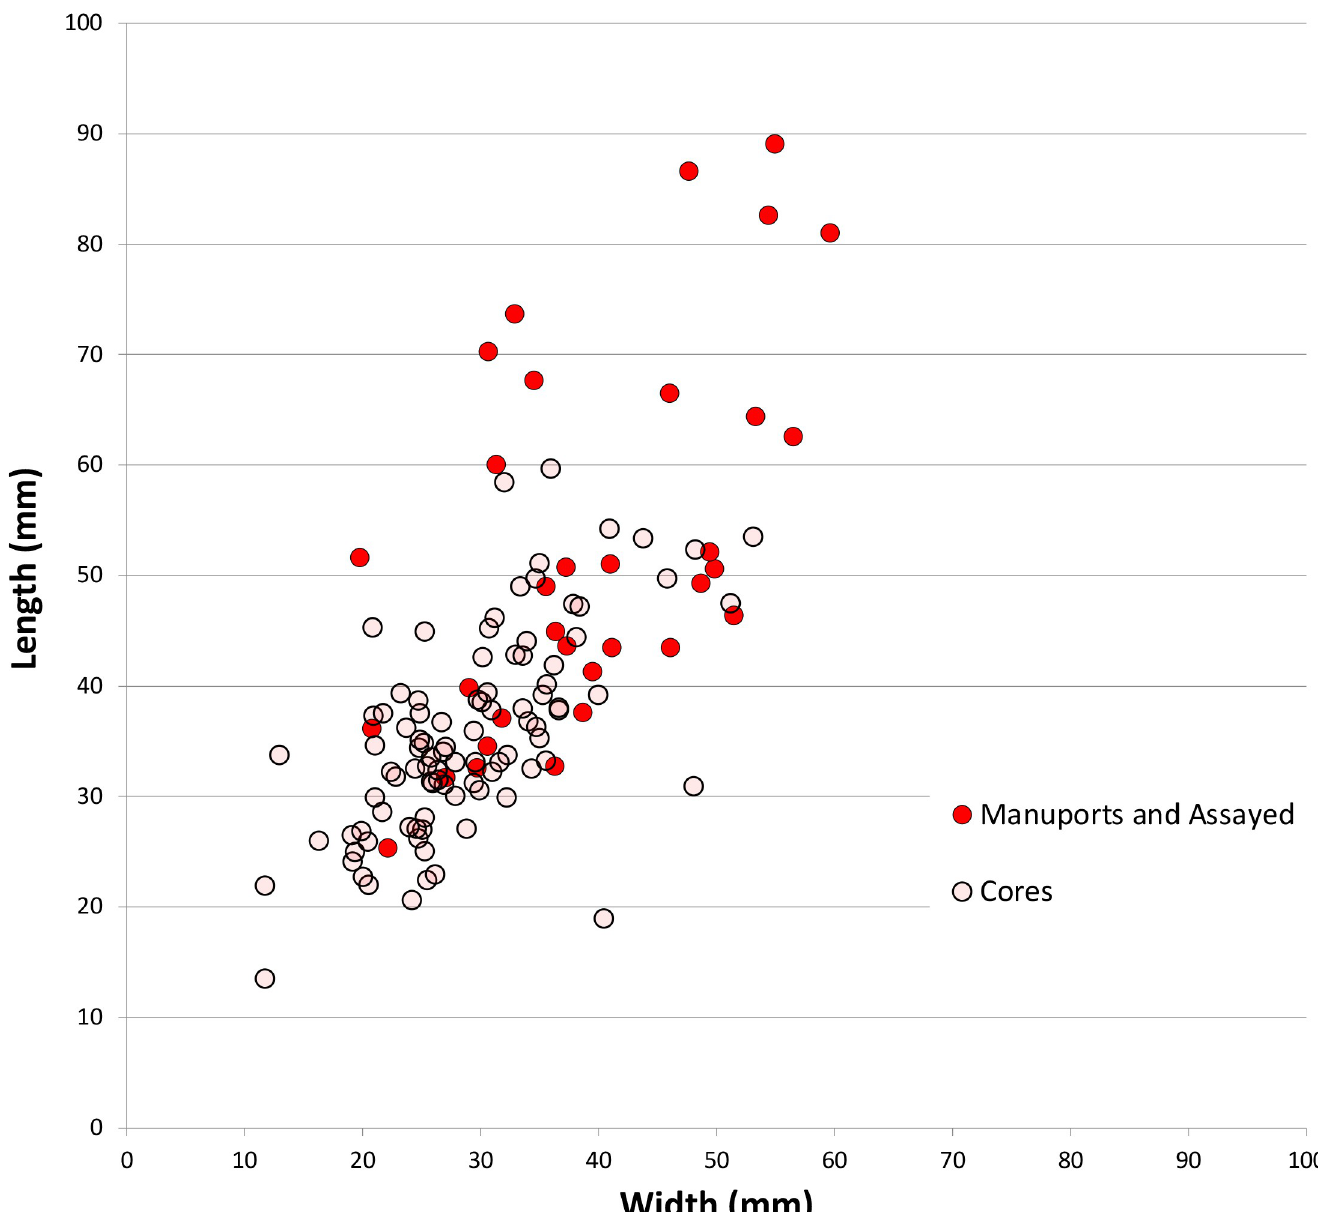
Fig 12. Scatterplot comparing core sizes to manuport/assayed chert cobble sizes, Horizon IV, Saruq al-Hadid.